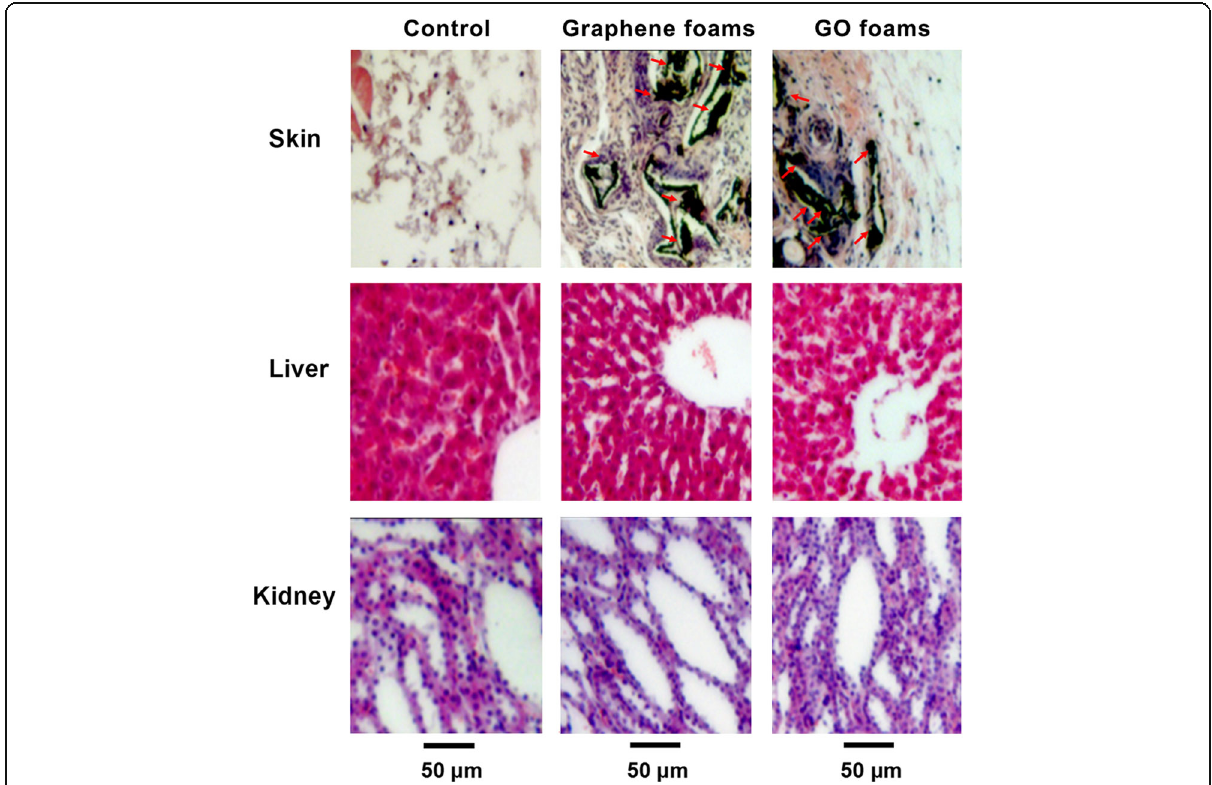
Fig. 1 Representative HE-stained images of major organs (implantation region, liver, and kidney collected from the rats) implanted with graphene foams, GO foams, or nothing at day 14 post-implantation. No obvious organ damage or lesion was observed. Reproduced from ref. [40] with permission from the Journal of Nanoparticle